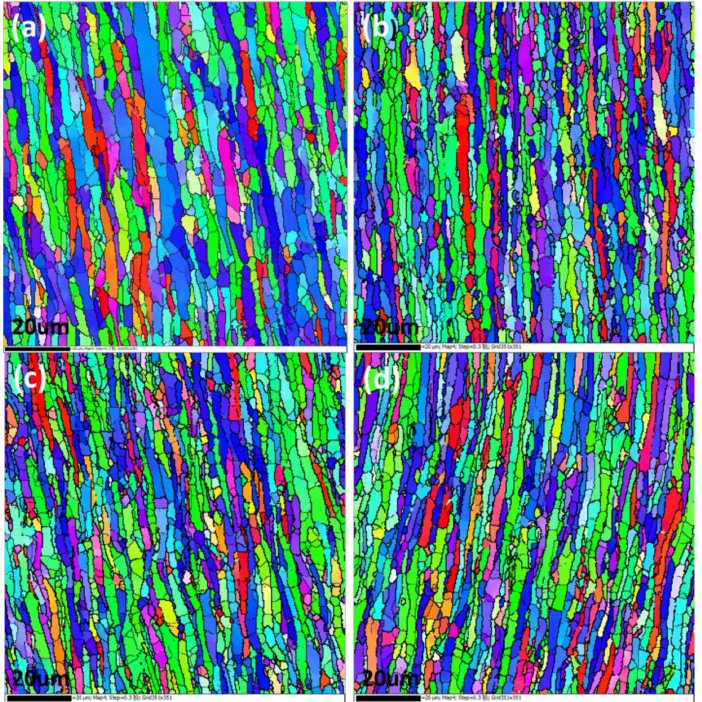
Figure 9. The inverse pole figure (IPF) map with grain boundaries for composites ( a ) pure aluminium;